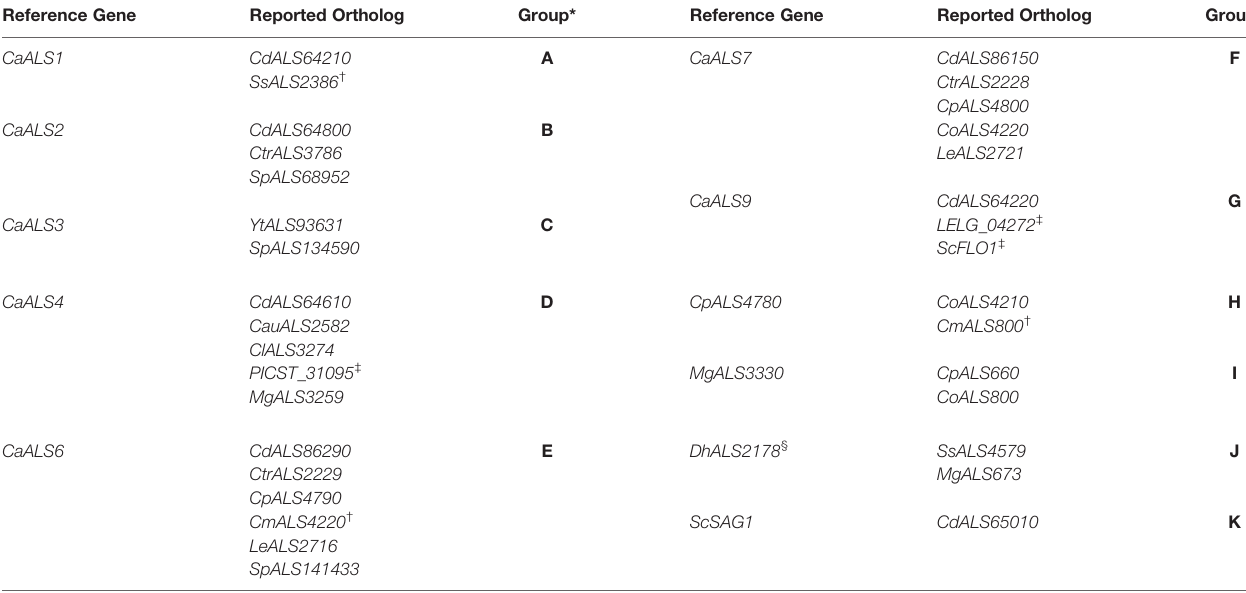
TABLE 3 | Orthologous ALS loci reported on Candida Gene Order Browser (CGOB). Reference